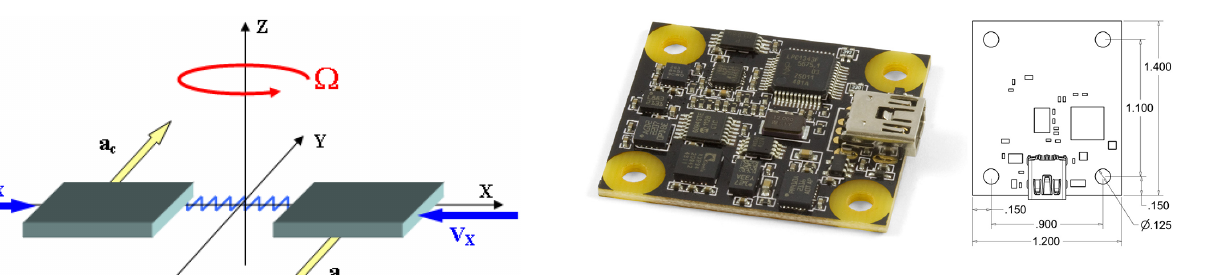
Figure 2. MEMS model 1044_0 (3/3/3 PhidgetSpatial Precision High Resolution) produced by the Canadian company Phidget Inc.; the reported measures are in inches.